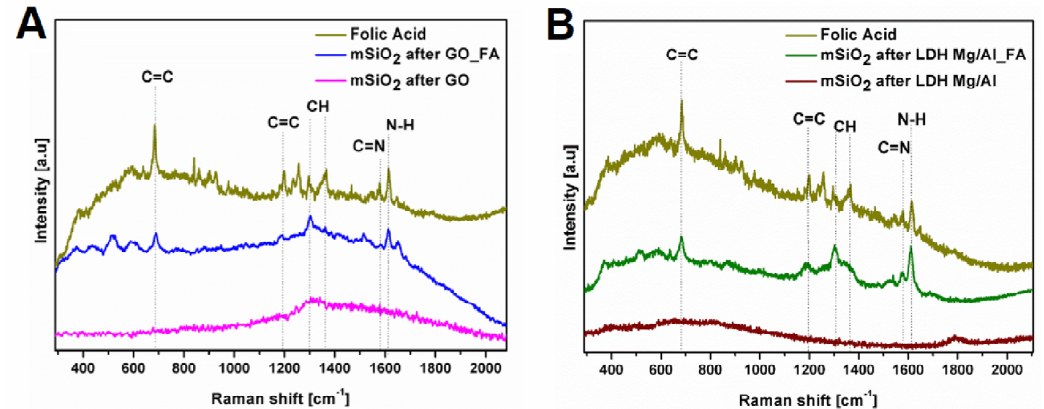
Figure 4. Raman spectra of silica flakes functionalized with folic acid: mSiO 2 after LDH Mg / Al_FA ( A ) and mSiO 2 after GO_FA ( B ).